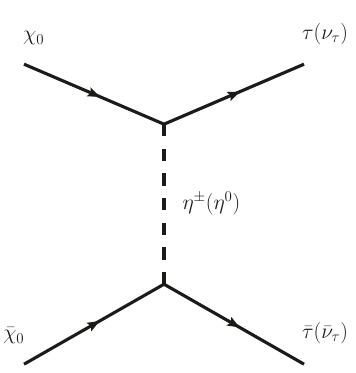
Figure 15 . The most dominant annihilation channels contributing to the relic density. This is particularly true when the other input parameters are fixed at the values shown in table